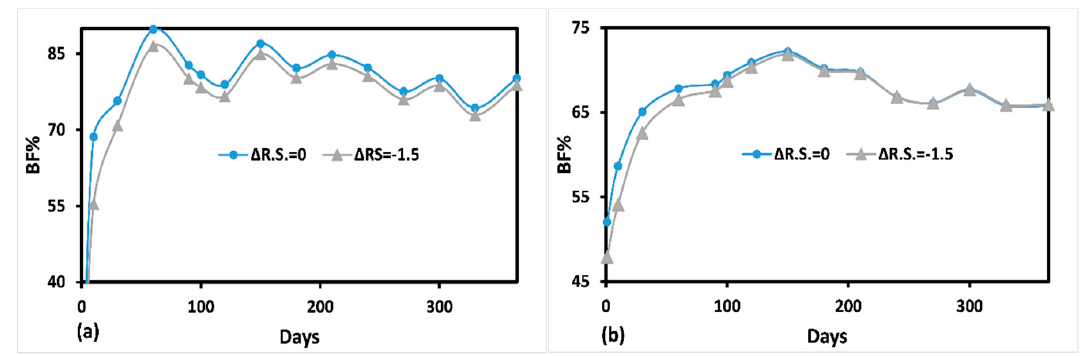
Figure 7. Influence of river stage dropping on bank-filtrate share (BF %) at two proposed sites: ( a ) Site 1 and ( b ) Site 2 at Aswan City (Egypt).